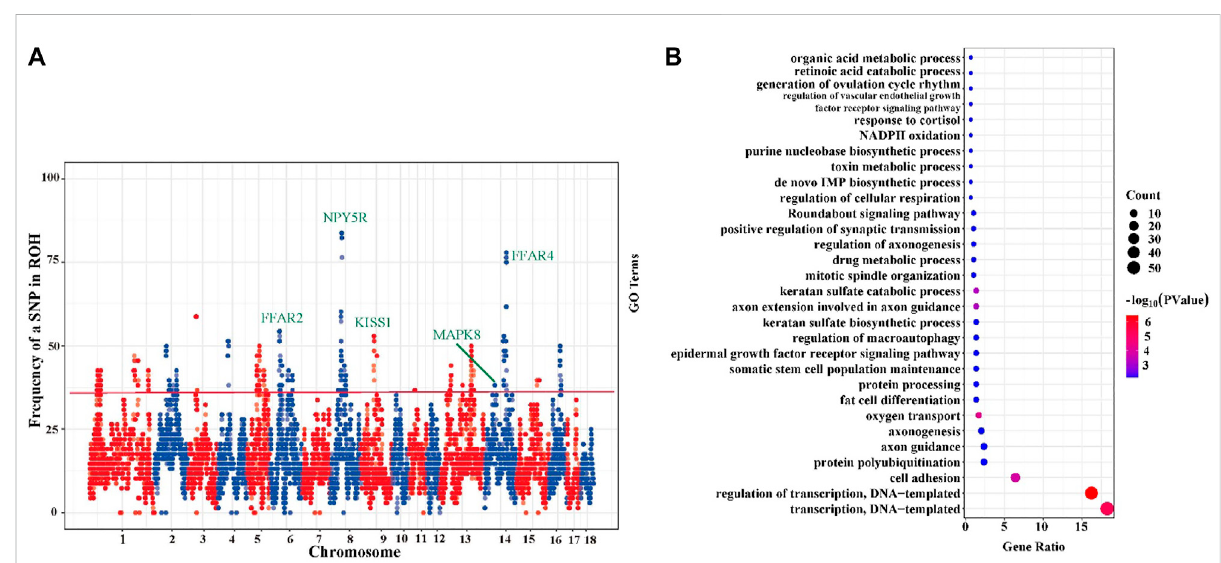
FIGURE 4 Incidence of each SNP in all runs of homozygosity (ROH) and the GO enrichment analysis of candidate genes. (A) Incidence of each SNP in all ROH segment. Particular genomic positions can be seen, on chromosomes 3,4,6,8,9,13,14,15,16 featured in ROH which were shared in over 50% of the sampled animals. (B) Bubble chart of GO terms enriched ( p < 0.05) based on ROH islands. The larger the bubble, the more genes are enriched in this term, and the darker the red, the smaller the p